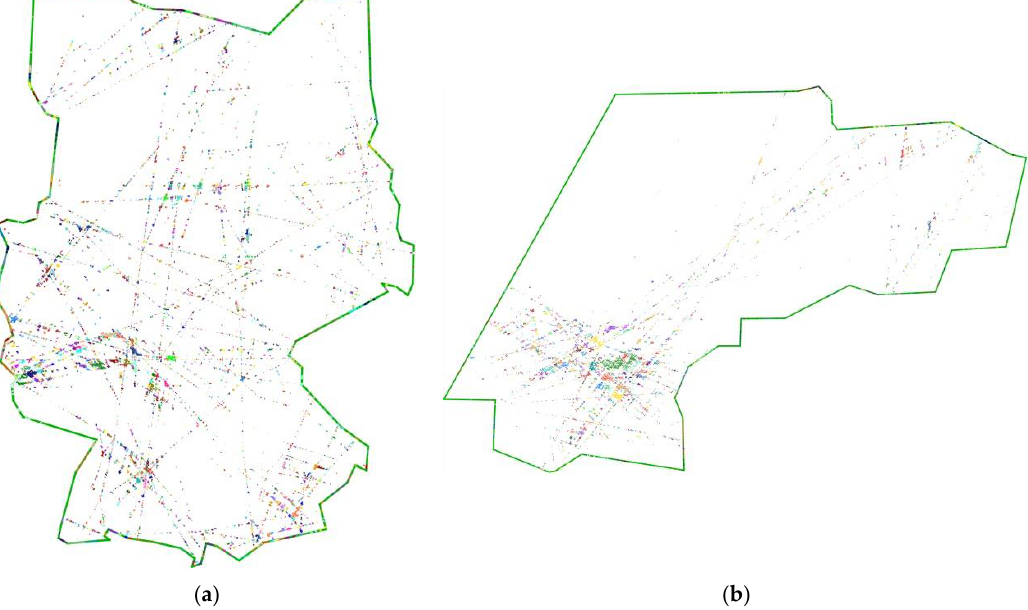
Figure 10. Cluster elements (small dots) for Scenario 1 ( a ) and 2 ( b ) without noise. Each color marks a cluster. a